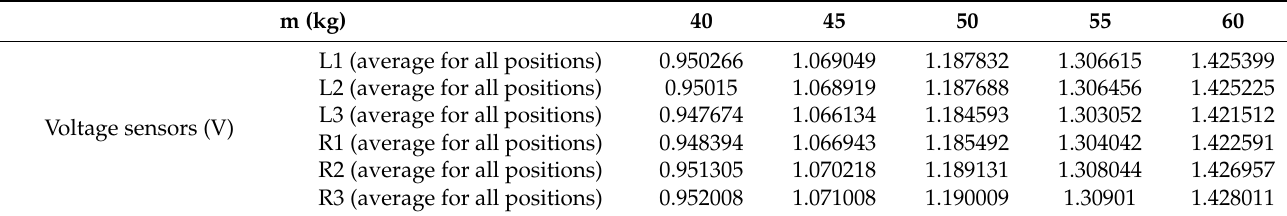
Table 2. Piezo sensor average voltage reading over all distances.